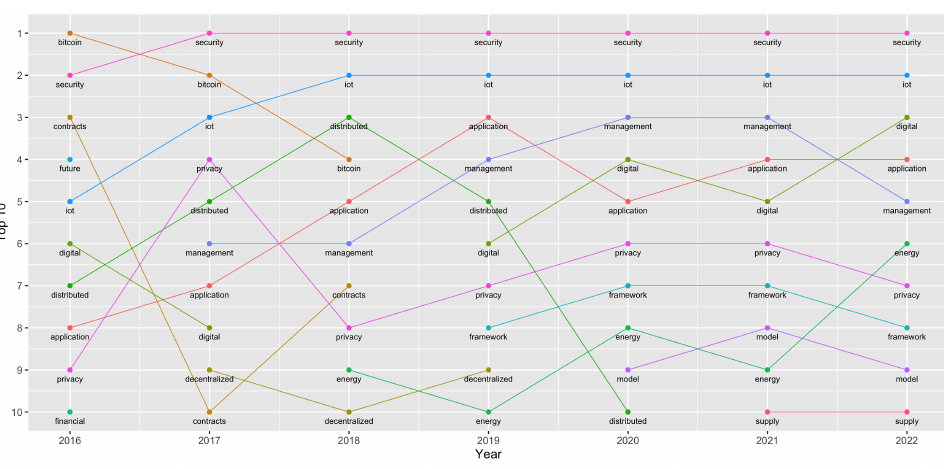
Figure 2. Top 10 most-used words and their